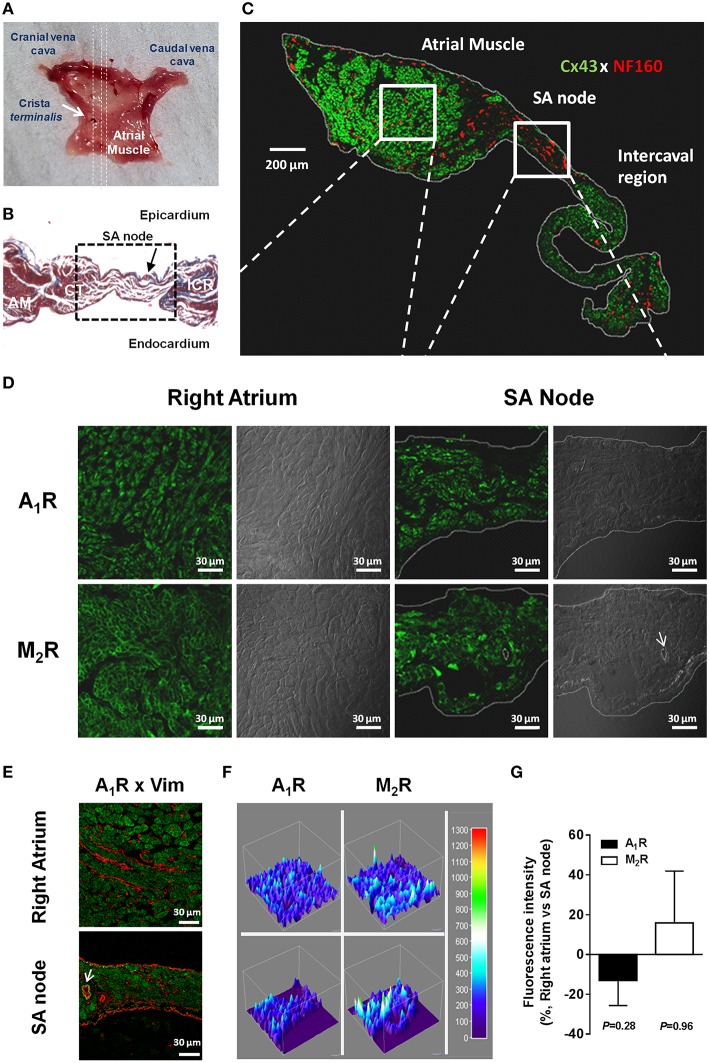
Anatomical and molecular identification of the rat SA node (A–C). (A) Endocardial view of a typical rat atrial muscle-SA node preparation. Dashed lines indicate the orientation of cuts performed on the right atrial appendage for Masson's trichrome staining and immunofluorescence analysis. (B) High-magnification (400x) images of Masson's trichrome staining of SA node (dashed box) and surrounding regions; AM, atrial muscle; CT, crista terminalis; ICR, intercaval region. Red staining, myocytes; blue staining, connective tissue. Black arrow indicates the SA node artery. (C) Montage of confocal optical sections showing immunolabelling for connexin 43 protein (Cx43, green signal) and neurofilament 160 (NF160, red signal) throughout the right atrial appendage from the rat. Boxes depict representative areas of the right atrium muscle and SA node used for immunolocalization of receptors and ion channels. (D) Representative confocal micrographs of the rat SA node and neighboring atrial muscle showing immunofluorescence labeling of A1 (upper panels) and M2 (lower panels) receptors; the corresponding differential interference contrast (DIC) images are also shown for comparison. (E) Please note that immunolabelling of A1 receptors (green) did not co-localize with vimentin (Vim) staining (red), which was used as a fibroblast-cell marker. Similar results were obtained in six additional experiments. The white arrow indicates the SA node artery. (F) Tridimensional surface modeling representing immunoreactivity of images depicted in panel (D). Color bar represents relative fluorescence intensity map. (G) Graph depicting semi-quantitative analysis of A1R and M2R expression in right atria and SA node; the ordinates are immunofluorescence intensity ratio between A1R and M2R staining in paired samples from the right atrium and SA node keeping the image acquisition settings constant. Positive and negative values indicate staining predominance in contractile myocardium and SA node of the right atrium, respectively. Values are mean ± SEM; at least 3 microscopic fields were analyzed per section of the right atrium and SA node obtained from three to seven rats. P > 0.05 indicates that no significant differences were found in the expression of A1R and M2R between the two atrial regions.